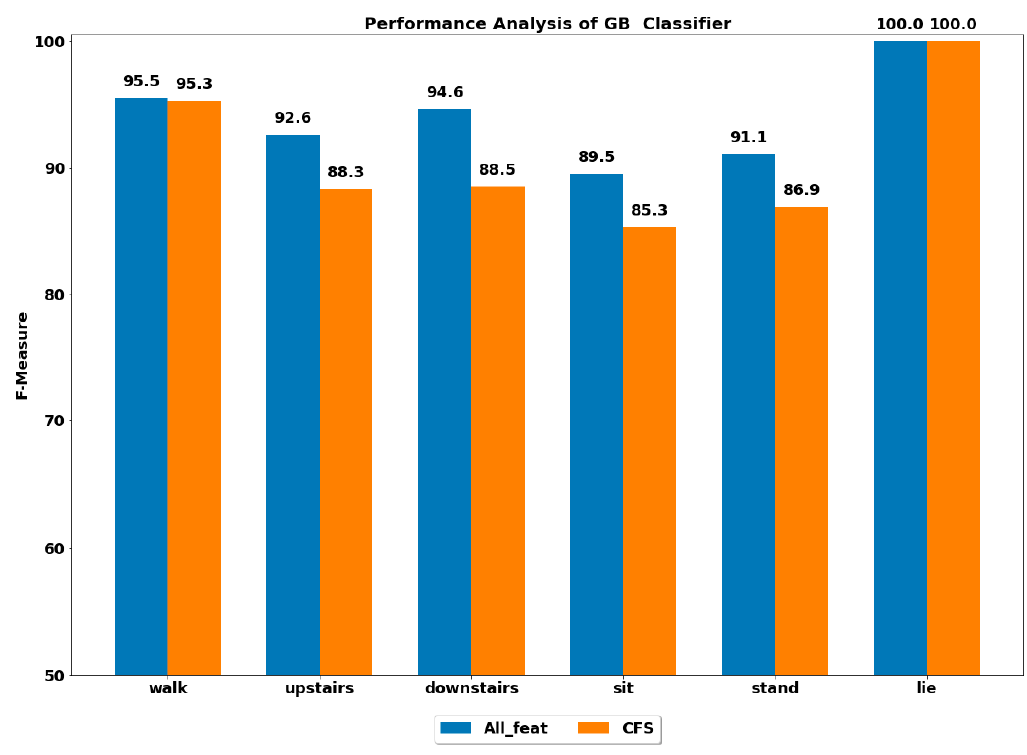
Figure 4. Performance analysis of LGBM (light gradient boosting Machine) classifier with and without feature selection to classify set of ADLs.